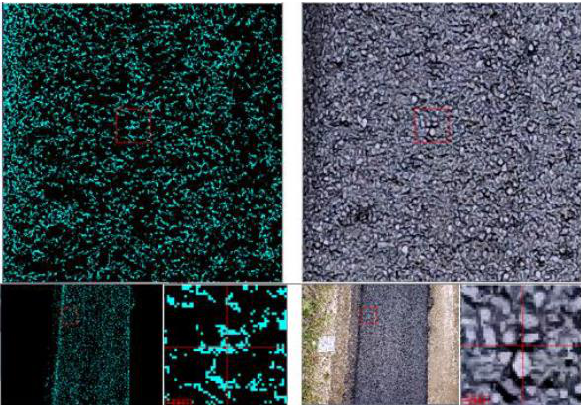
Figure 6. Initial distribution of stone objects And finally, based on the processing of the still images, it was possible to detect how these machines were changing the macro texture during the construction process from the original asphalt collocation (figure 6) to the final asphalt surface (figure 7). Both examples belong to the same section of the paved road, the three images on the right (figure 6), correspond to the original image captured from the RPAS, in the instant after the asphalt was placed. The set of images on the left (figure 6) corresponds to the result of the digital image processing. The cyan pixels represent the darkest pixels (DN close to zero) in the original Figure 4 . Pneumatic roller